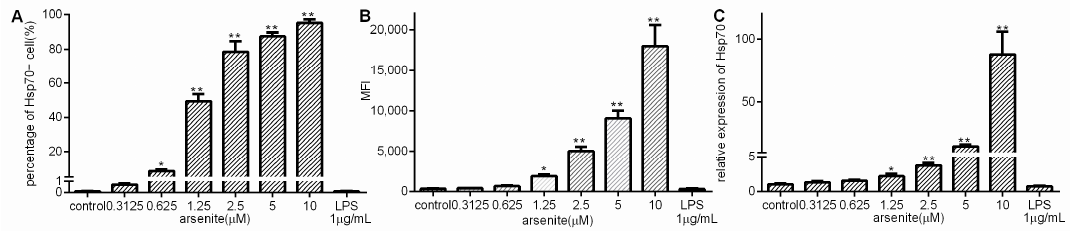
Figure 1. The induction of Hsp70 production in arsenite-stressed 030D cells. 030D cells were either left untreated, or exposed to the indicated concentrations of arsenite or LPS (1 µg/mL) for 16 h. ( A ) The percentages of Hsp70-positive cells detected by flow cytometry using FITC-labeled Hsp70 specific antibody. ( B ) Mean fluorescence intensities (MFI) of Hsp70 positive cells. ( C ) The mRNA expression of Hsp70 was measured by qPCR. Data are shown as the mean ± SD and are representative of three independent experiments. * p < 0.05, ** p < 0.01, vs. control group.